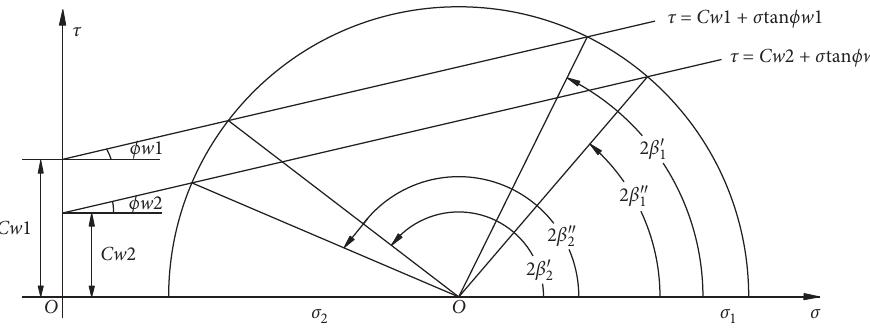
Figure 1: Strength analysis of rock mass with a dual structural